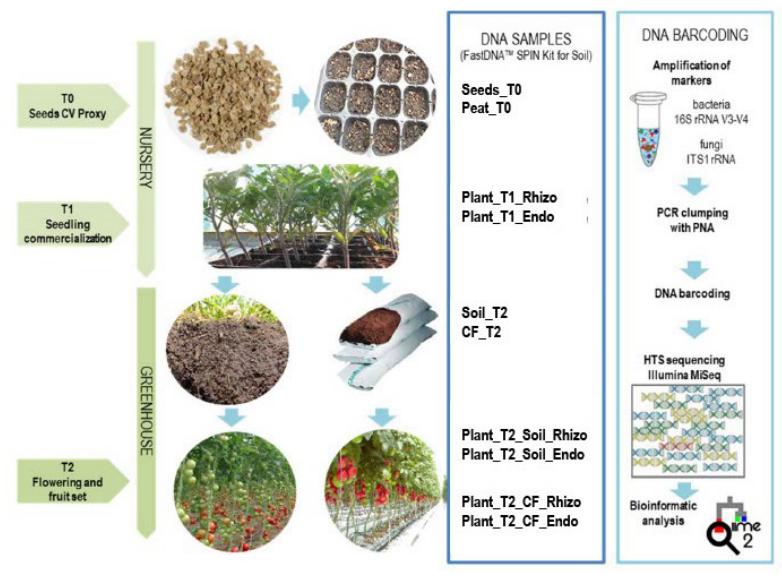
Figure 1. Experimental design workflow for sampling and processing to study bacterial and fungal communities by amplicon-based metagenomics.